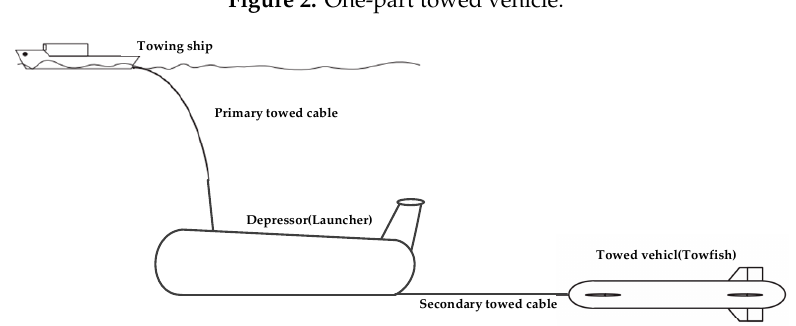
Figure 2. One-part towed vehicle.